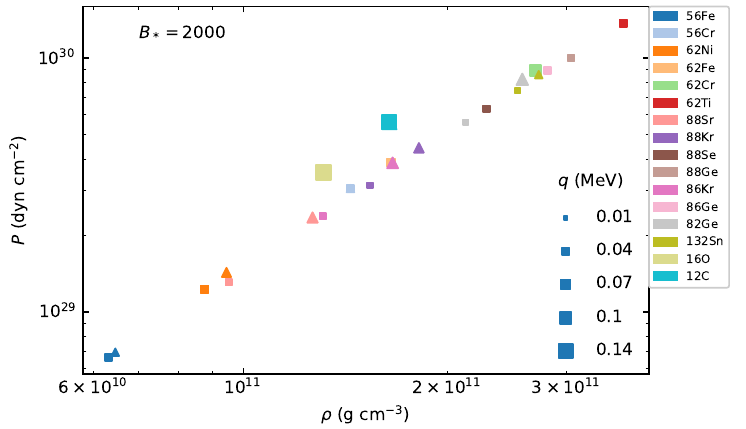
Figure 3. Heat q released per nucleon (in MeV) from selected electron captures by nuclei in the outer crust of a magnetar with a magnetic field strength B (cid:63) = 2000 in a pressure P (in dyn cm − 2 )–mass density ρ (in g cm − 3 ) diagram, considering transitions from the ground state of the parent nucleus to either the ground state (squares) or the first excited state (triangles) of the daughter nucleus. The size of each symbol is proportional to the amount of heat deposited as indicated.